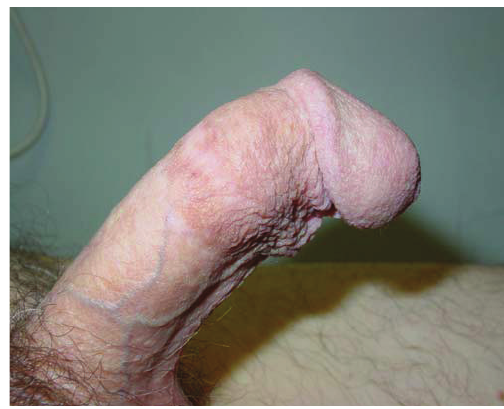
Figure 4: A “Concorde” e ff ect due to undersized